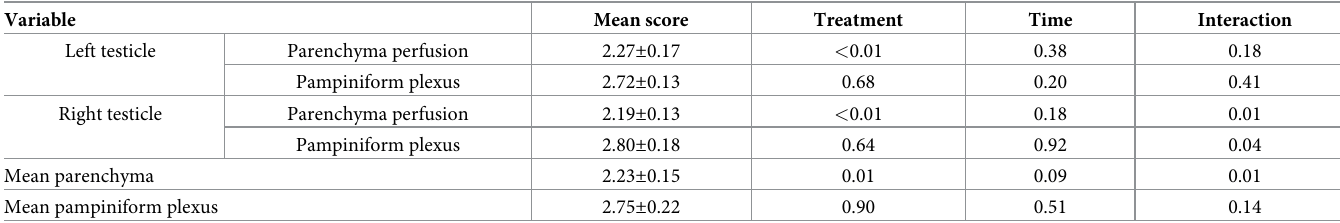
Mean pampiniform